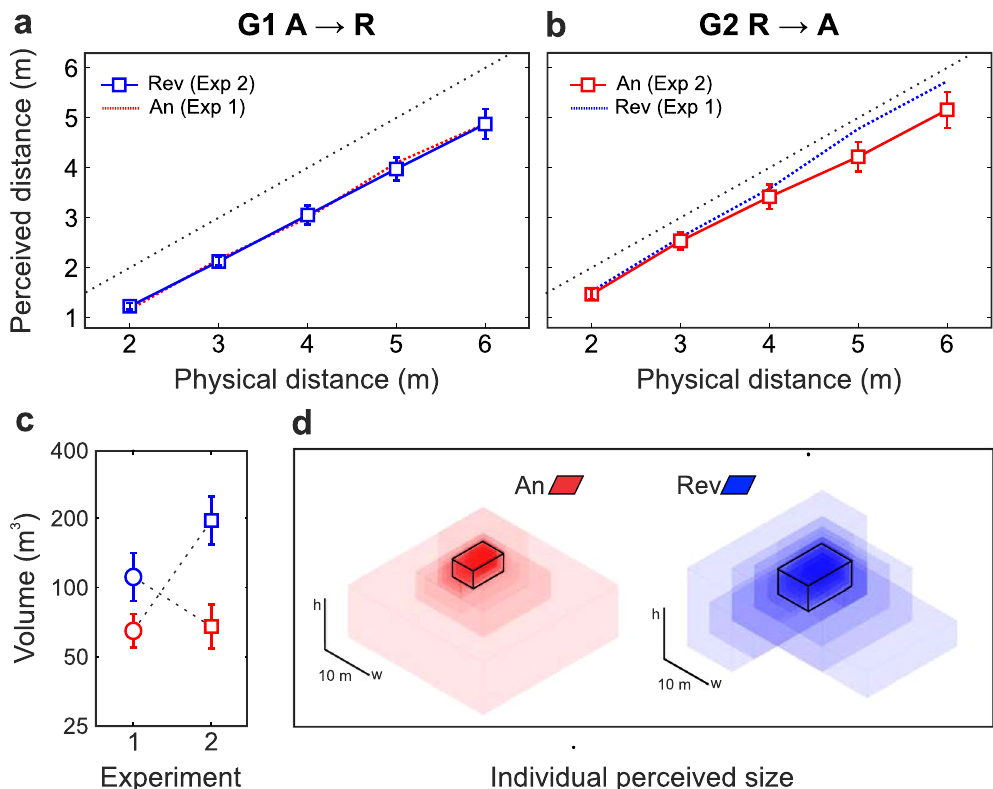
Figure 3. Results of Experiment 2 and comparison with Experiment 1: ( a ) Distance curves (mean response ± SEM as a function of target distance) for Group 1. Subjects went from the anechoic chamber (Experiment 1, red dotted line) to the reverberant room (Experiment 2, blue solid line). ( b ) Same as previous for Group 2. Subjects went from the reverberant room (Experiment 1, blue dotted line) to the anechoic chamber (Experiment 2, red solid line). In both panels, the black dotted lines indicate perfect performance. ( c ) Mean perceived volume for each room in both experiments. Data for each group are joined with dotted lines. ( d ) Each transparent box corresponds to the individual perceived dimensions (width, length and height) for each condition (anechoic chamber: left section, in red; reverberant room: right section, in blue). For each room, the box in solid black lines represents the average of each dimension (taken separately) across